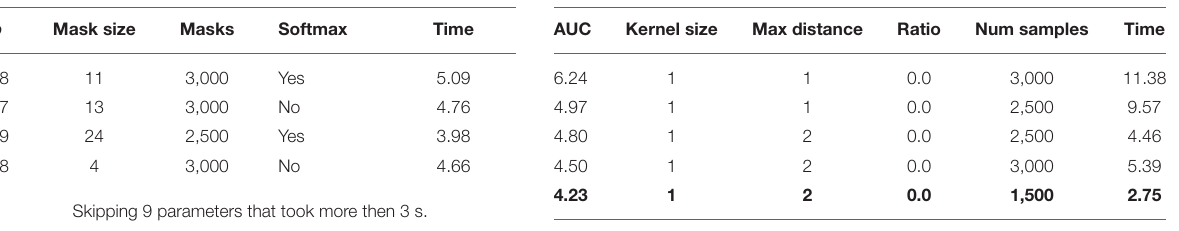
TABLE 7 | Best parameters for LIME with Quickshift